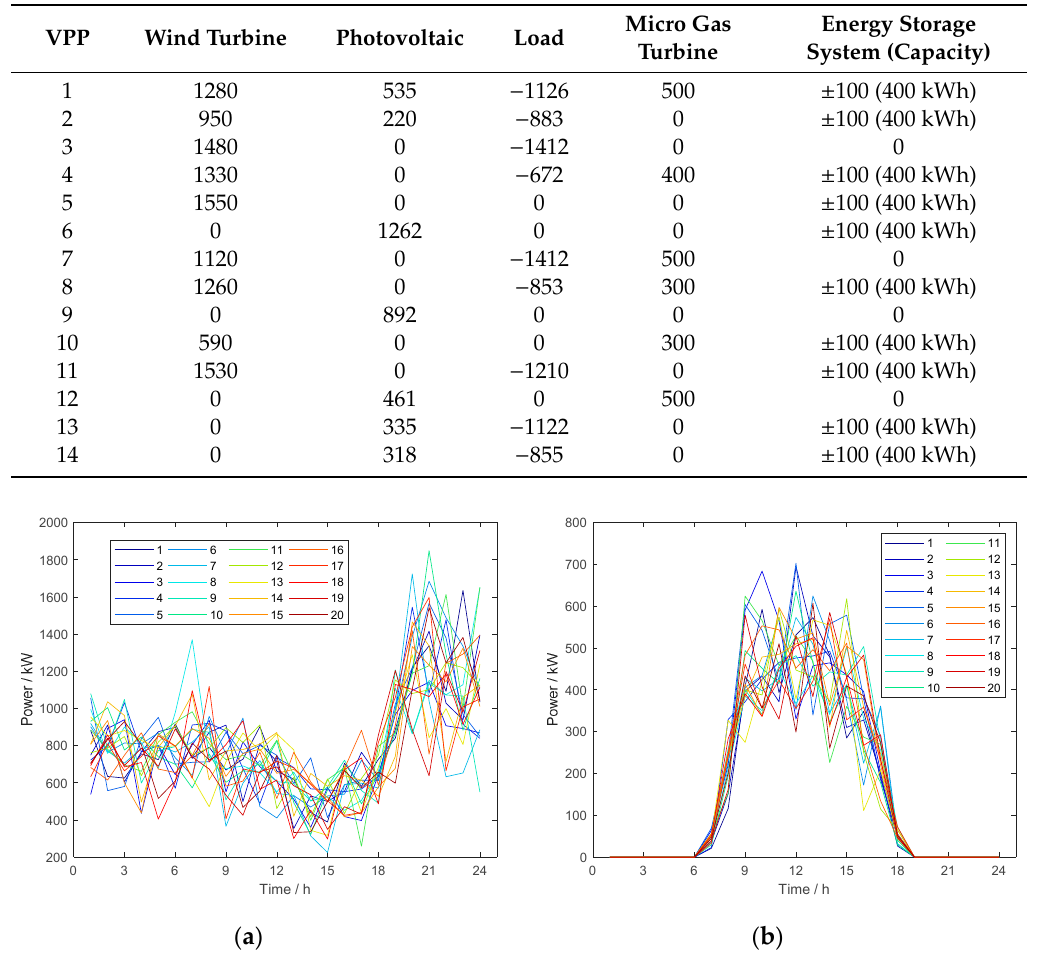
Table 1. Nominal parameters of internal DERs in VPPs (kW).